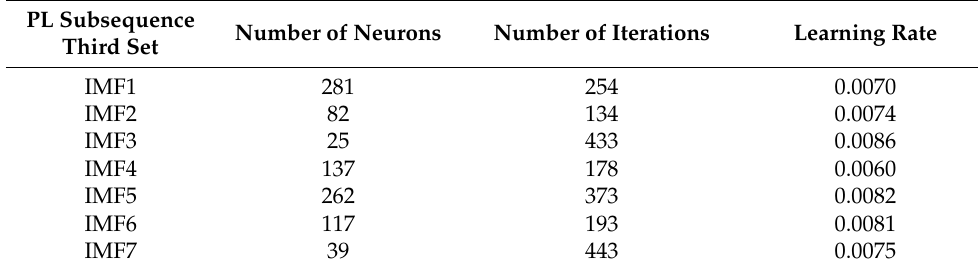
Table 9. Results of hyperparameters optimized by PSO based on third set